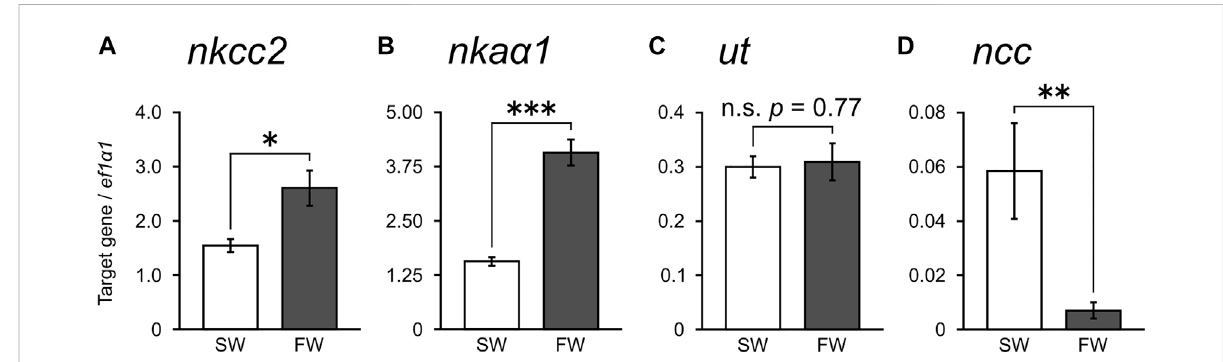
FIGURE 2 Expression oftransportermRNAsinthekidneymeasuredbyreal-timeqPCR.mRNAsfor nkcc2 (A) , nka α 1 (B) , ut (C) ,and ncc (D) werequanti fi ed and normalized against those of elongation factor 1 α 1 ( ef1 α 1 ). N = 6 in each group. Asterisks indicate statistically signi fi cant differences between SW control and FW-acclimated stingrays (* p < 0.05, ** p < 0.01, *** p < 0.001).